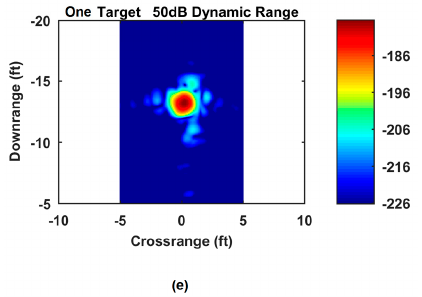
Figure 13. Fused images of a single target over 30–50 dB image dynamic range: ( a ) 30 dB; ( b ) 35 dB; ( c ) 40 dB; ( d ) 45 dB; ( e ) 50 dB.